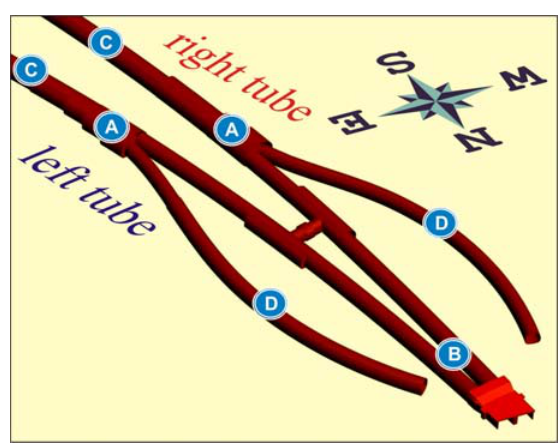
Figure 1. Scheme of the Šentvid tunnel